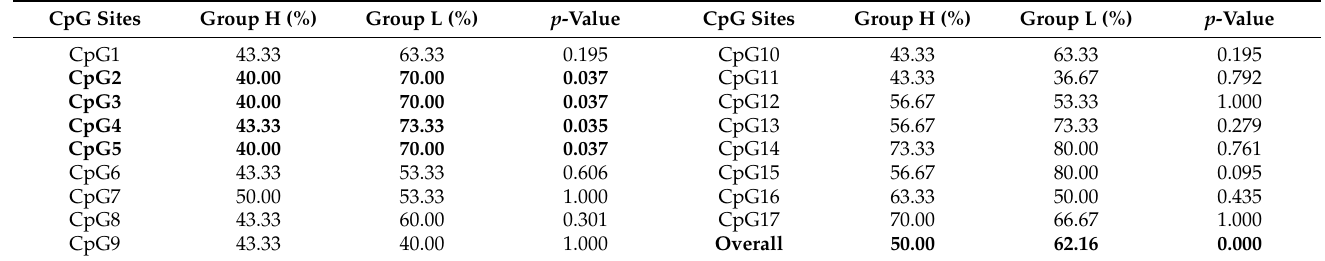
Table 5. Methylation levels of CpG III sites in the high and low yield groups.